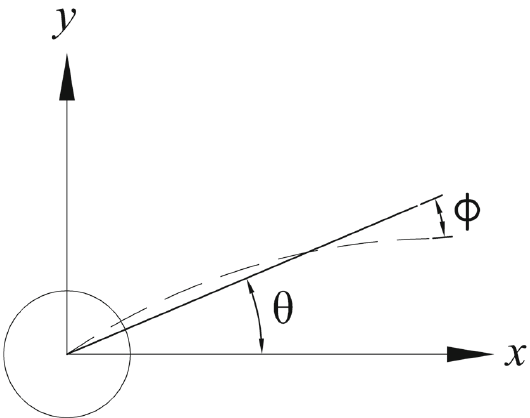
Figure 4. Single Flexible link